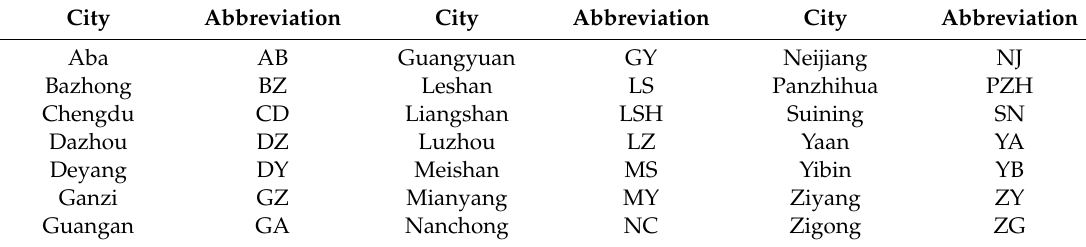
Figure 1. The study area. Table 1. The 21 cities in Sichuan Province.